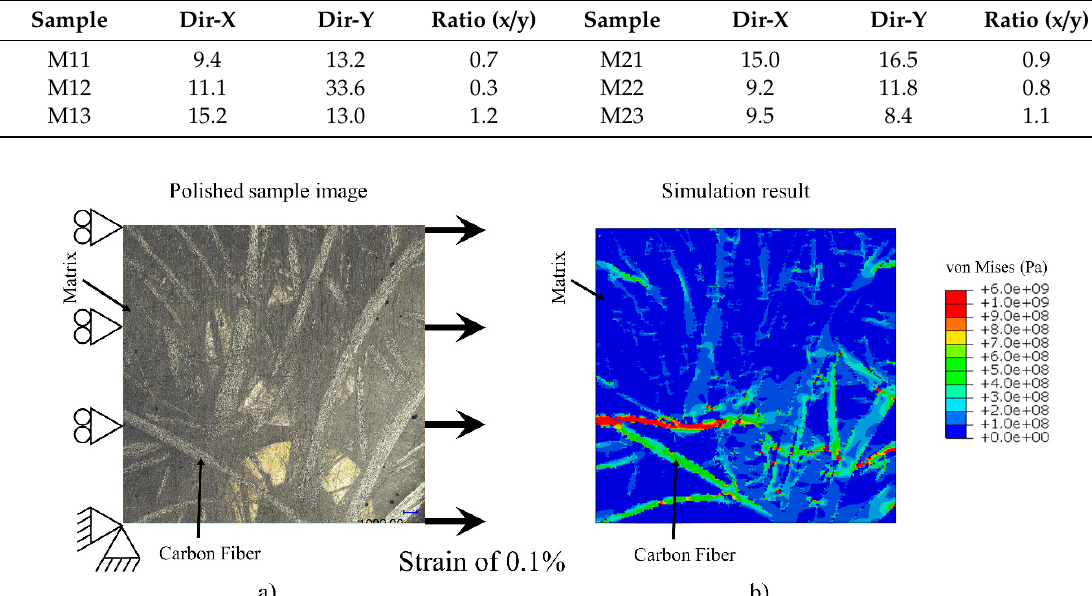
Table 1. Tensile Modulus in GPa as predicted by the OOF based FEA study.